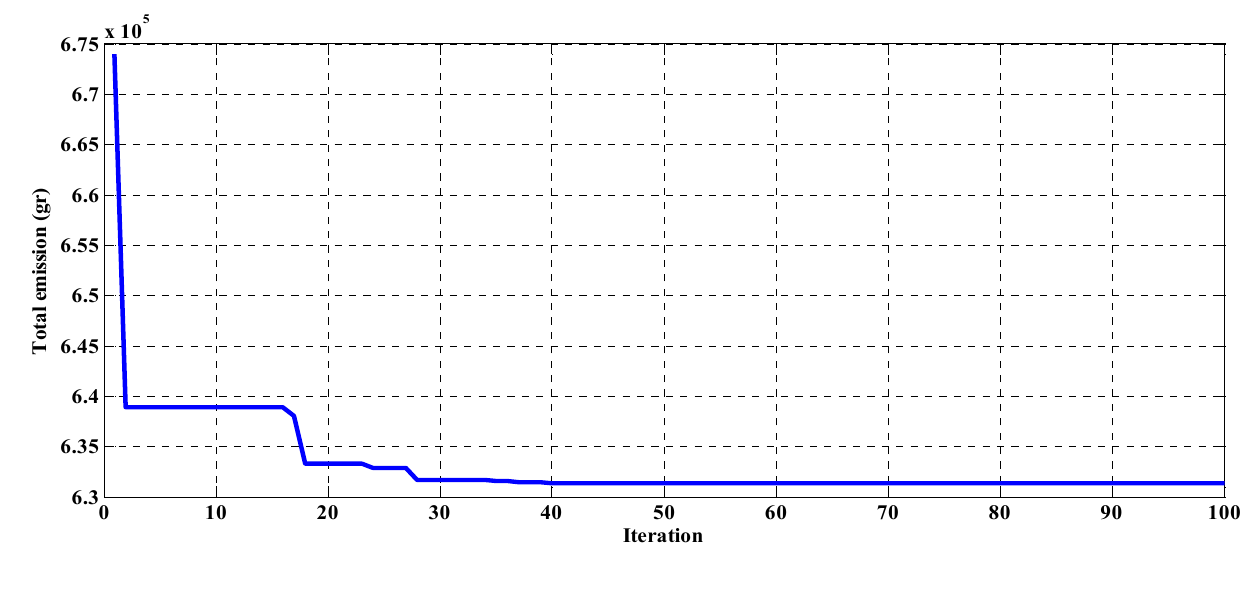
Figure 9. Convergence plot of FAMPSO for Voltage deviation